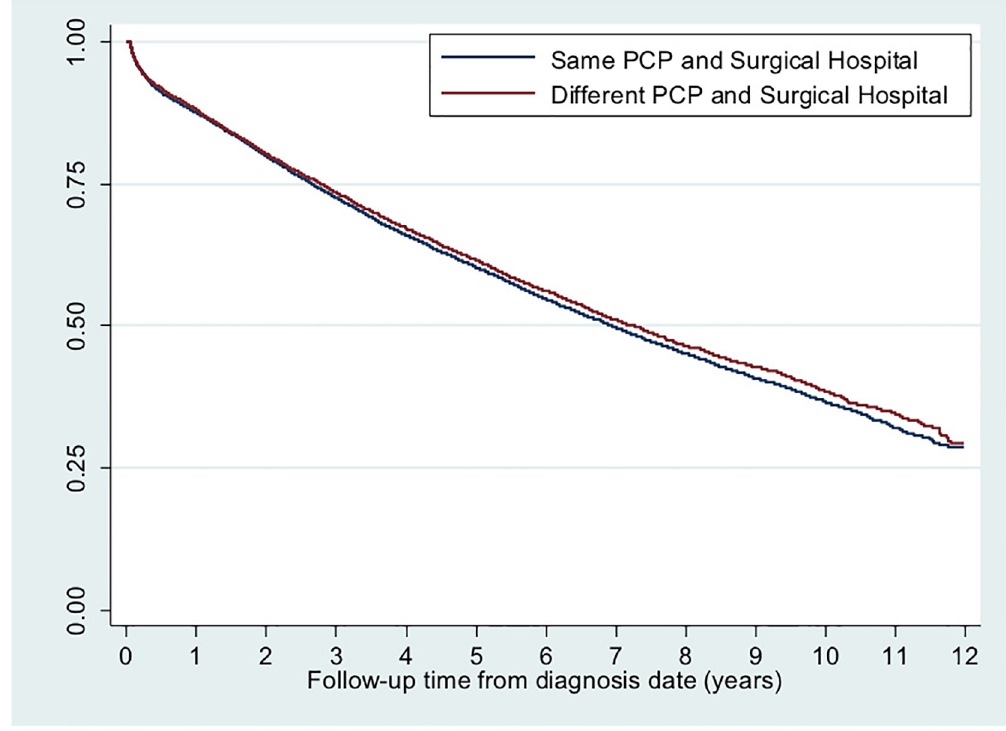
Fig 2. Kaplan Meier survival curve for all-cause mortality by same versus different hospital primary and surgical care delivery. Average follow-up time: 4.8 years. Total follow-up time: 112,820 years. Log rank survival function: chi square = 0.22, p = 0.52. Test of non-zero slope: p = 0.31.